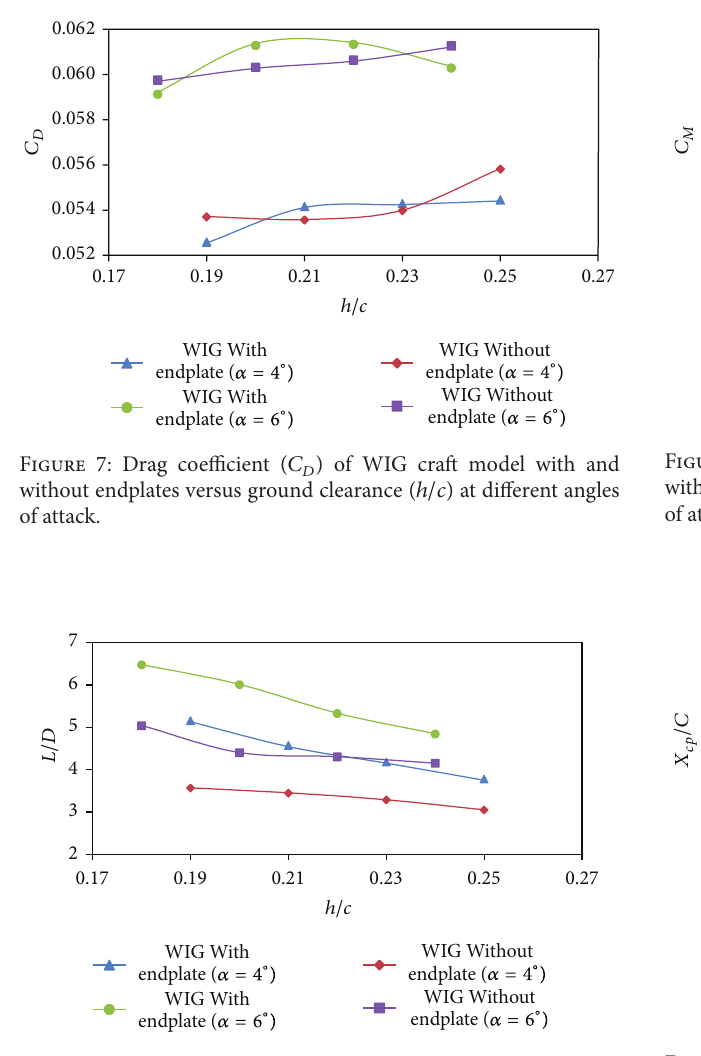
Figure 8: Lift-to-drag ratio ( 𝐿/𝐷 ) of WIG craft model with and without endplates versus ground clearance ( ℎ/𝑐 ) at different angles of attack.